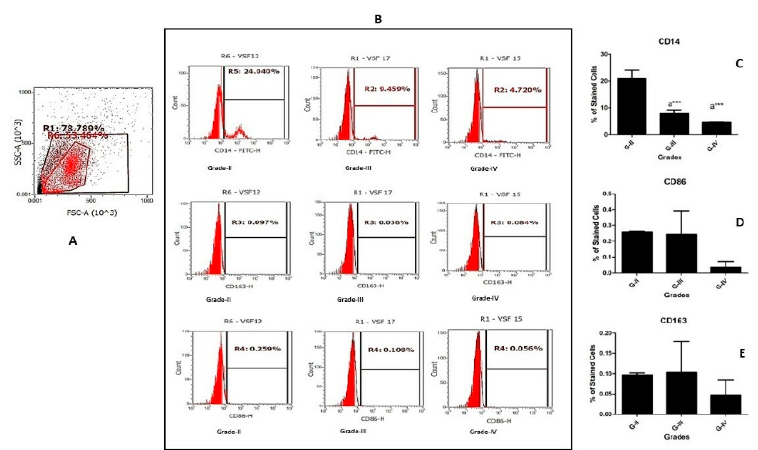
Figure 1. Immunophenotyping of SF samples. Twelve freshly collected SF samples were subjected to immunophenotyping to estimate monocyte/macrophage percentage. ( A ) denotes the gating strategy established from isotype control for the selection of cell population. ( B ) shows representative histograms of macrophages and their subset analysis in OA SFs from KL grade II, III, and IV; for the quantification of macrophages and their subsets, the used antibody panel included cell surface markers like CD14 (pan-macrophage marker), while CD86 and CD163 represent M1 and M2 phenotype of macrophages, respectively. Values in the quadrant represent the percentage of positive cells. ( C – E ) are the bar graphs, representing a grade-wise staining pattern of CD14+, CD86+, and CD163+ cells in SF samples; for the graph plotting, the average of each cell surface marker obtained from three SF samples of each KL grade was used (n = 12). a statistical significance in comparison to G-II; * p < 0.05, ** p < 0.01, *** p < 0.001.